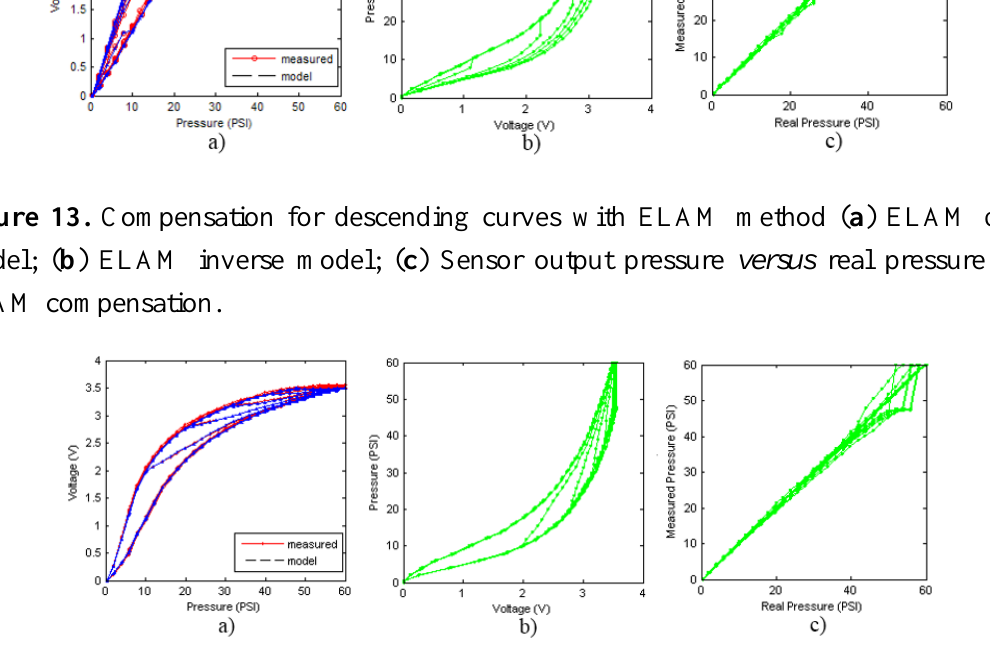
Figure 14. Compensation for ascending curves with ELAM method ( a ) ELAM direct model; ( b ) ELAM inverse model; ( c ) Sensor output pressure versus real pressure after ELAM